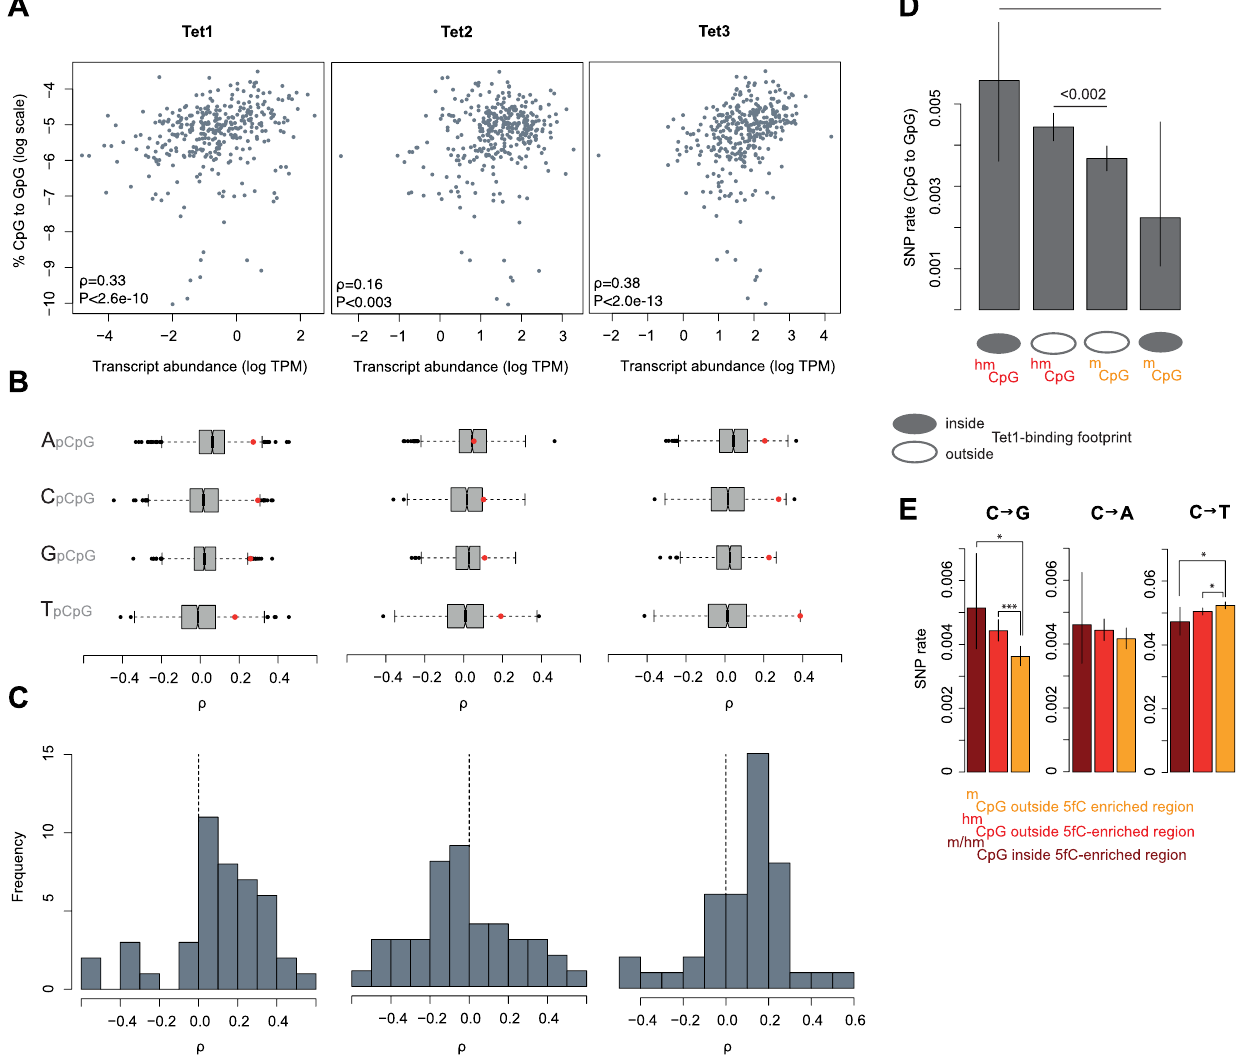
Figure 4. The expression and binding of Tet enzymes correlates with C to G rates. (A) Expression levels of Tet1 and Tet3, but not Tet2, correlate with C to G somatic mutation rates across 346 cancer genomes. (B) For different upstream contexts, correlation coefficients (Spearman’s rho) between C to G rates and expression levels were computed for the three Tet genes (red dots) and their respective set of control genes (grey/black, see main text). Whiskers extend to approximately 1.5*IQR (interquartile range) below/above the bottom/top quartile of the data, (see R documentation [69] for details). (C) Distribution of correlation coefficients (C to G rates , Tet expression) calculated independently for 44 different cancer type-upstream context combinations. (D) C to G SNP rates at 5hmC and 5mC sites as a function of Tet1-binding in mESCs. (E) Rates of cytosine loss for the matched set of sites as a function of location inside or outside 5fC-enriched regions in mESC as defined by [32]. Error bars are 95% confidence intervals, calculated using Wilson’s interval score for single proportions. TPM: transcripts per